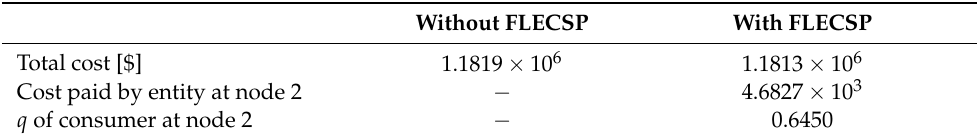
Table 8. Results of numerical tests—market with a